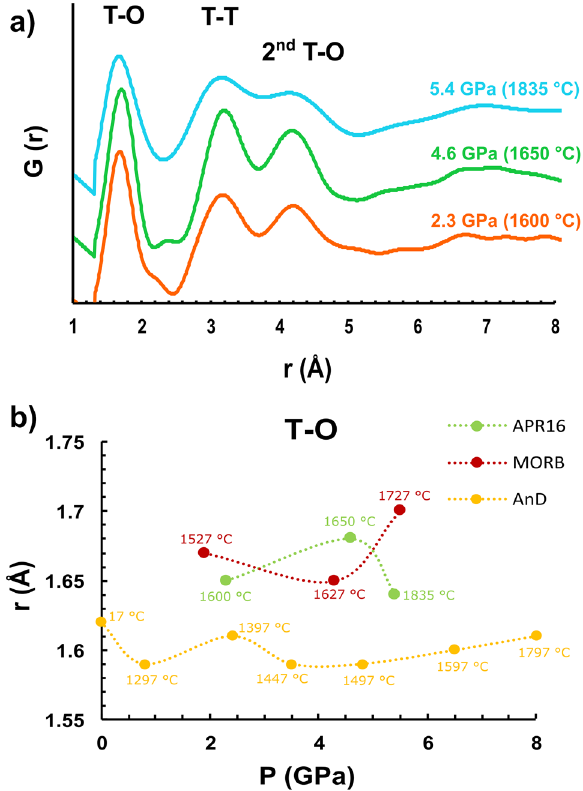
Figure 2. ( a ) Radial distribution function of the melt at the different investigated P of 2.3 GPa (1600 °C; orange), 4.6 GPa (1650 °C; green) and 5.4 GPa (1835 °C; light blue). The displayed peaks are relative to the tetrahedral-coordinated cation T-T, T-O and 2nd T-O interatomic distances. ( b ) T-O distance vs P for APR16 (in green) compared with data from Sakamaki et al . 8 (in red) and de Grouchy et al. 25 (in